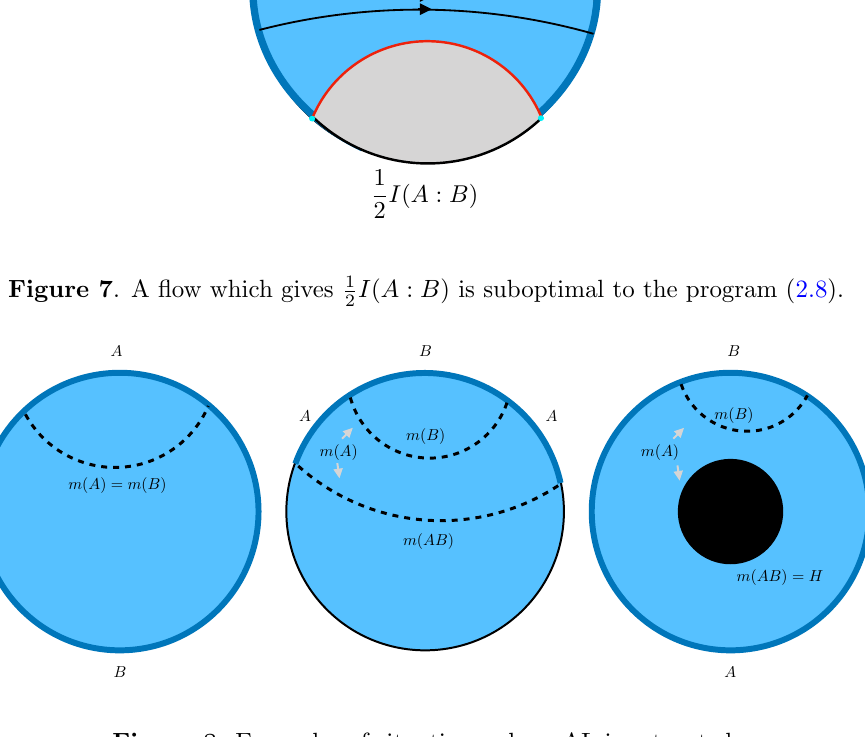
Figure 8 . Examples of situations where AL is